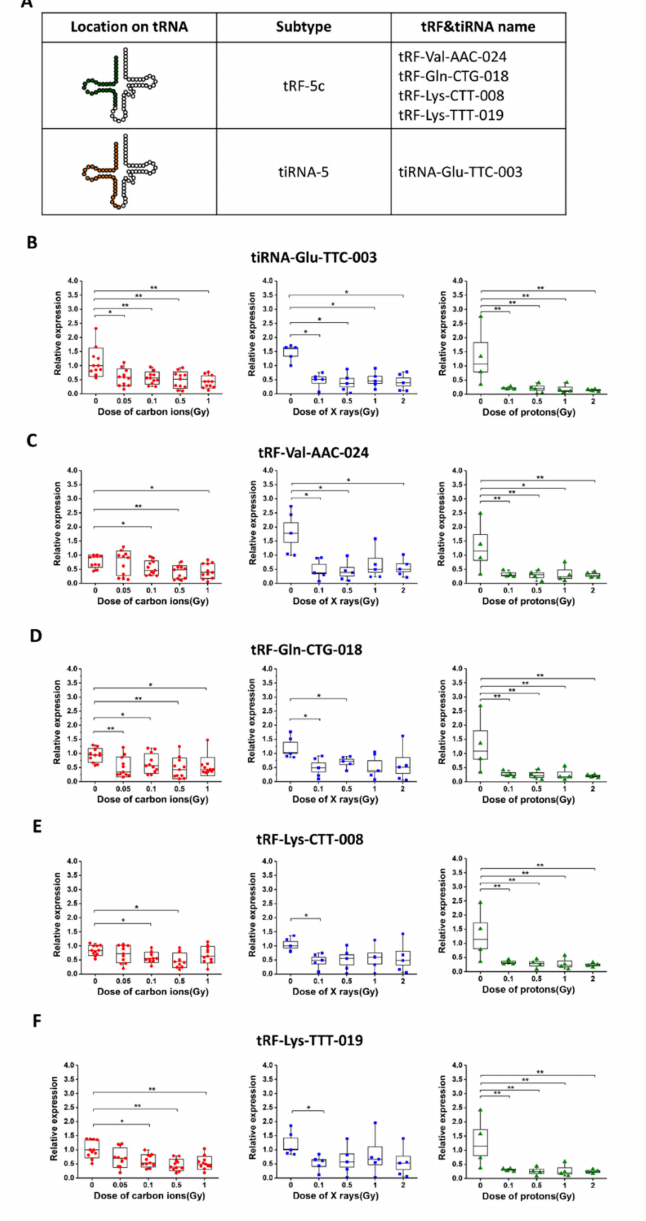
Figure 3. The dose responses of five selected tsRNAs after exposure of mice to carbon ions, X-rays, and protons. ( A ) Classification of the five selected tsRNAs (tiRNA-Glu-TTC-003, tRF-Val-AAC-024, tRF-Gln-CTG-018, tRF-Lys-CTT-008, and tRF-Lys-TTT-019) and their location on the structure of tRNA. ( B – F ) The relative expression of the five tsRNAs in response to different dose exposure of carbon ions ( n = 11/dose), X-rays ( n = 5/dose), or protons ( n = 4/dose). Each dot represents the relative expression of tRF or tiRNA in each individual, * p < 0.05, ** p < 0.01, compared with control group (0